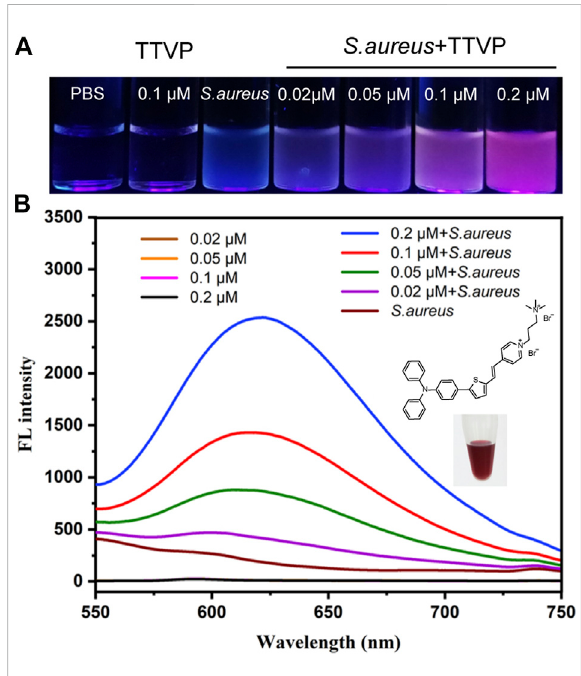
FIGURE 1 (A) The picture of S. aureus incubated with TTVP at different concentrations for 15 min under 365 nm UV light. (B) FL spectra of TTVP with or without incubation with S. aureus for 15 min (Excitation wavelength = 489 nm). The insert was the photograph of TTVP solution (5 mM) dissolved in